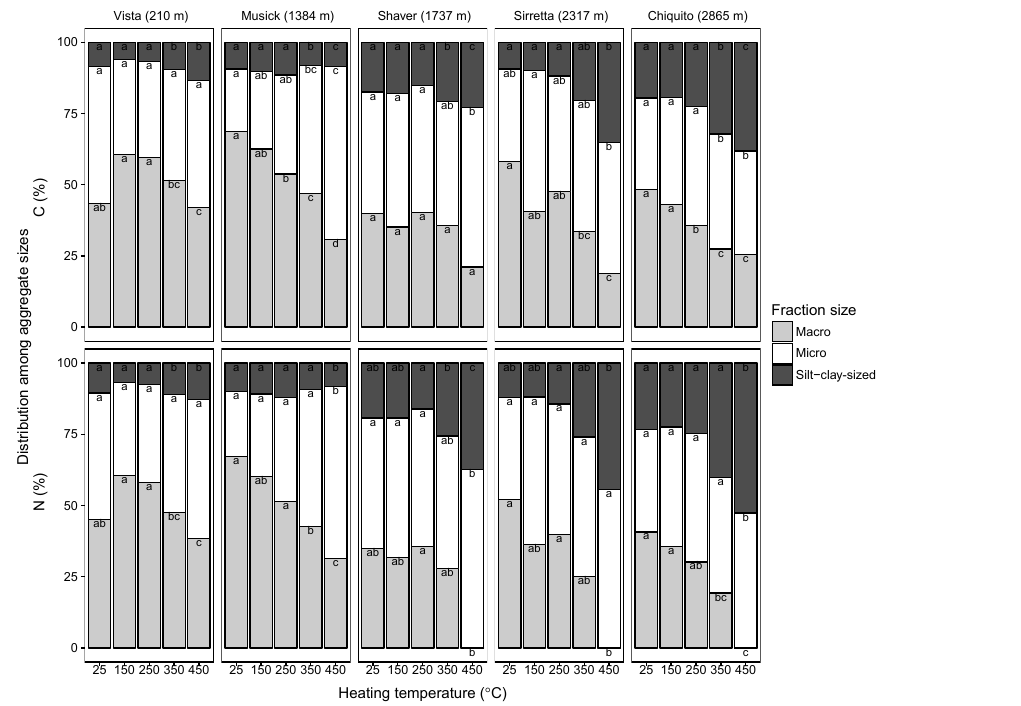
Figure 4. C and N distributions in macroaggregates (2–0.25mm), microaggregates (0.25–0.053mm), and silt–clay-sized ( < 0.053mm)